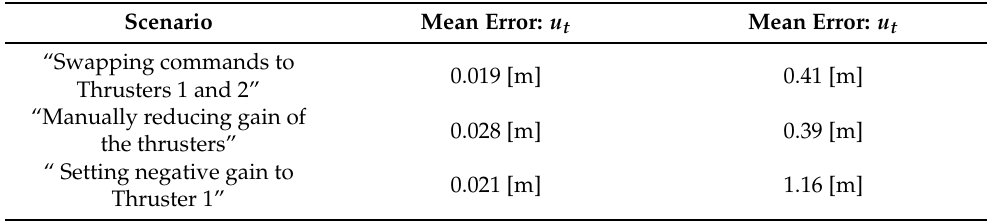
Figure 16. Mean square error of 100 trajectories of AUV regarding three scenarios. Table 2. Mean errors from three scenarios.